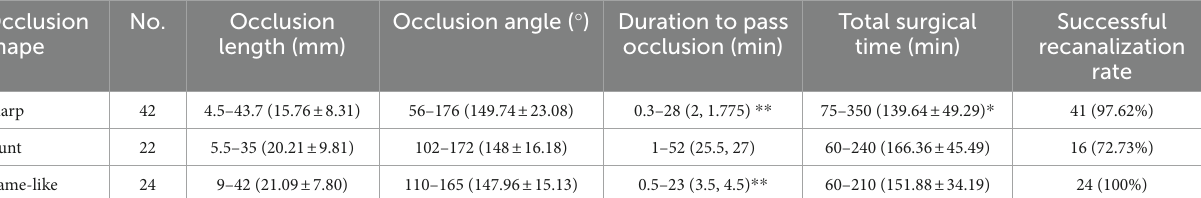
TABLE 3 Comparison of data in different shapes of occlusion.